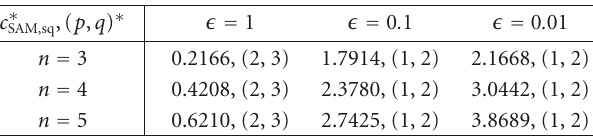
Table 1: The ( p , q )-optimal network throughput in bits-hops/s/ Hz/node of a network on the square grid under the SAM and non- fading